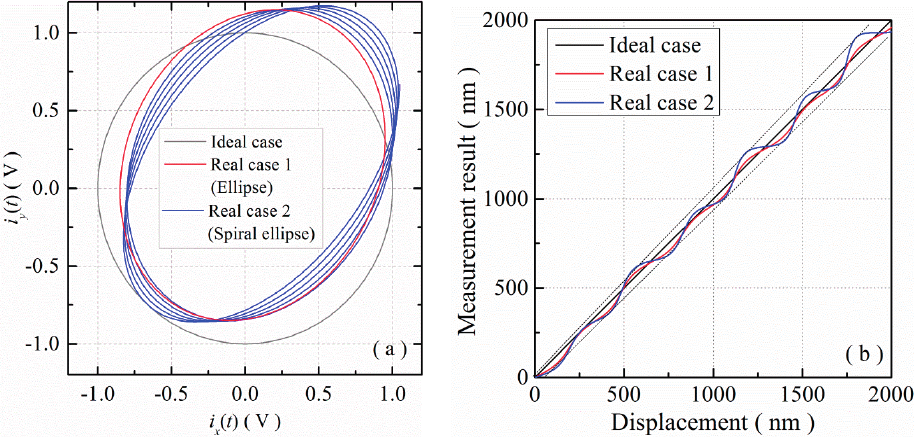
Figure 2. Trajectories of quadrature signals and displacement measurements in ideal and real cases: ( a ) trajectories and ( b )